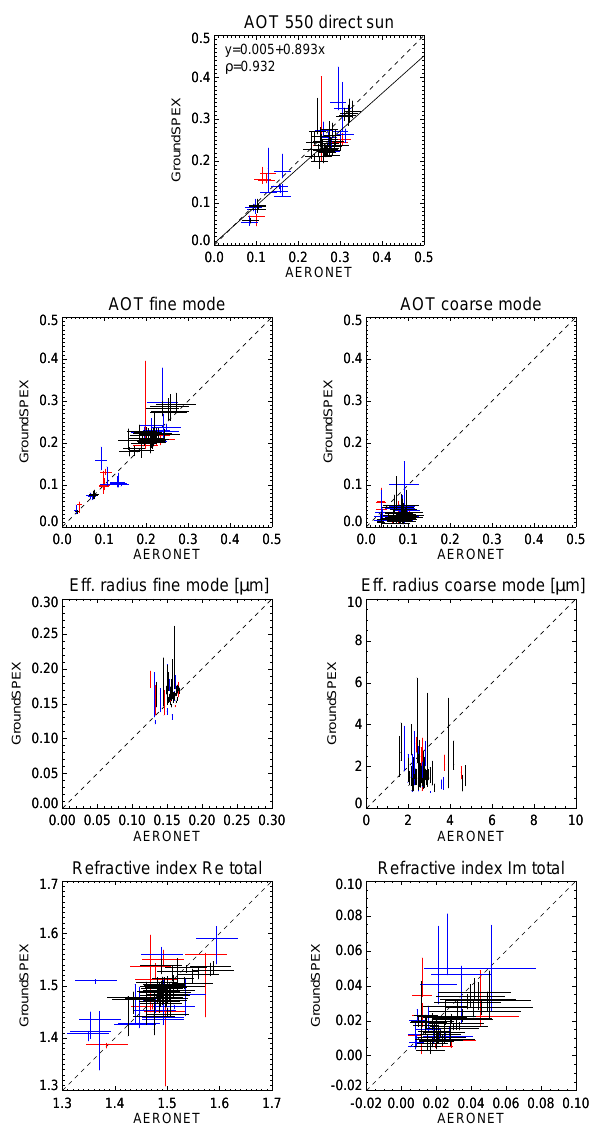
Figure 7. Aerosol parameters retrieved with the groundSPEX in- strument, compared to AERONET. The different colors correspond to different goodness-of-fit values of the retrieval: 5 ≤ χ 2 ≤ 10 (red), 2 ≤ χ 2 ≤ 5 (blue), and χ 2 ≤ 2 (black). The dashed lines in- dicate the groundSPEX = AERONET scenario. The measurements were performed on 7, 8, and 9 July and 5 September 2013 at Cabauw, the Netherlands.